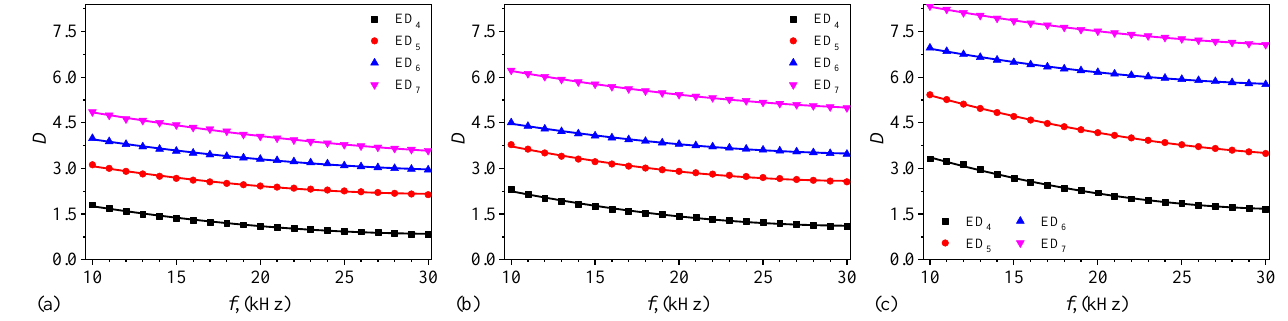
Figure 11. Variations in dielectric loss tangent D with the frequency f of a sinusoidal electric field at discrete values of the magnetic flux density B . ( a ) B = 0 mT. ( b ) B = 200 mT. ( c ) B = 400 mT. Using the data from Figures 10 and 11 in Equation (3), one obtains the variations in the resistance with frequency f , as shown in Figure 12. The data show that the resistance decreased with the addition of the microparticles. In particular, the highest decrease was at B = 0 mT, where the resistance of ED 7 was about one order of magnitude smaller than that of ED 4 . When B (cid:54) = 0, the differences between the resistances of ED 4 and ED 7 were less pronounced. Similar qualitative behavior also held for the time constant (Figure 13). Note that such behavior for the resistance and capacitance can be described qualitatively using